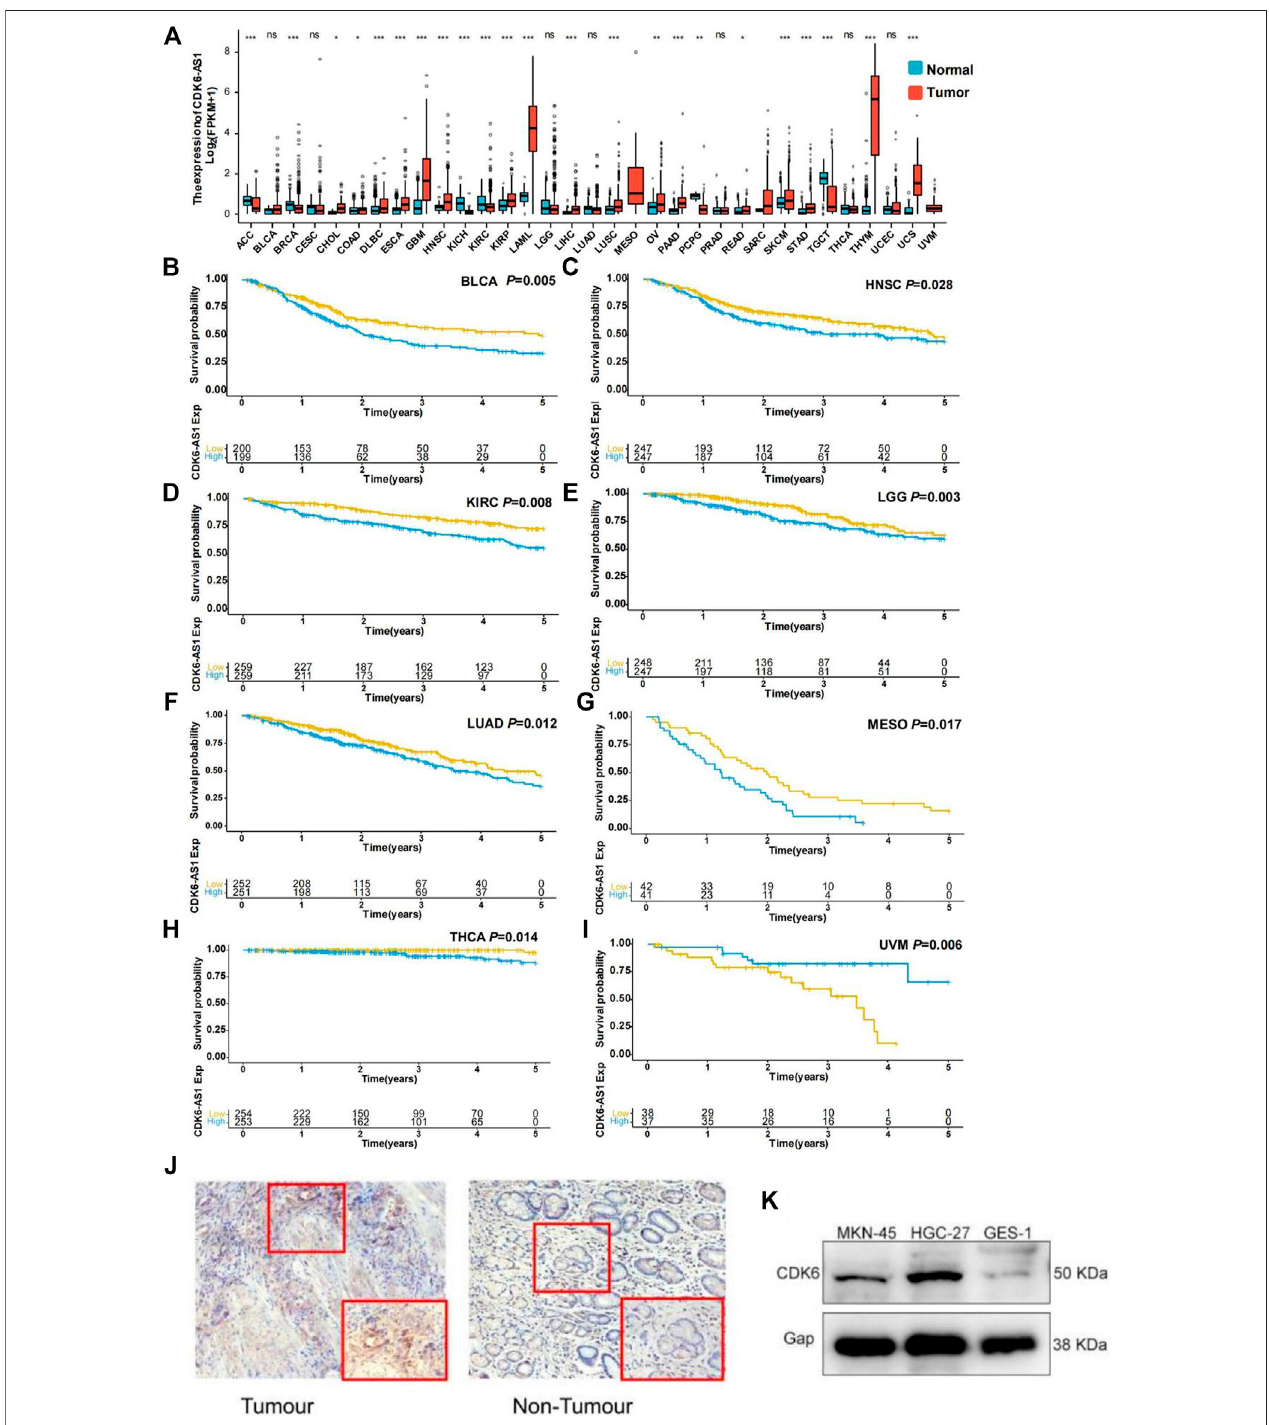
FIGURE 5 | Expression and survival validation in TCGA pan-cancer cohort. (A) Differential expression validation of CDK6-AS1 in TCGA pan-cancer cohort. * p e 0.05;** p < 0.01;*** p < 0.001;ns:notsigni fi cantwith p > 0.05. (B – I) Theprognosticeffectof CDK6-AS1 inotherTCGAcancertypes.TypeswithCox p > 0.05areshown. (J) Representative immunohistochemical staining for gastric cancer tumor-in fi ltrating target gene CDK6 . (K) The CDK6 was expressed in gastric cancer cells MKN-45, HGC-27, and gastric mucosa epithelial cells GES- 1.